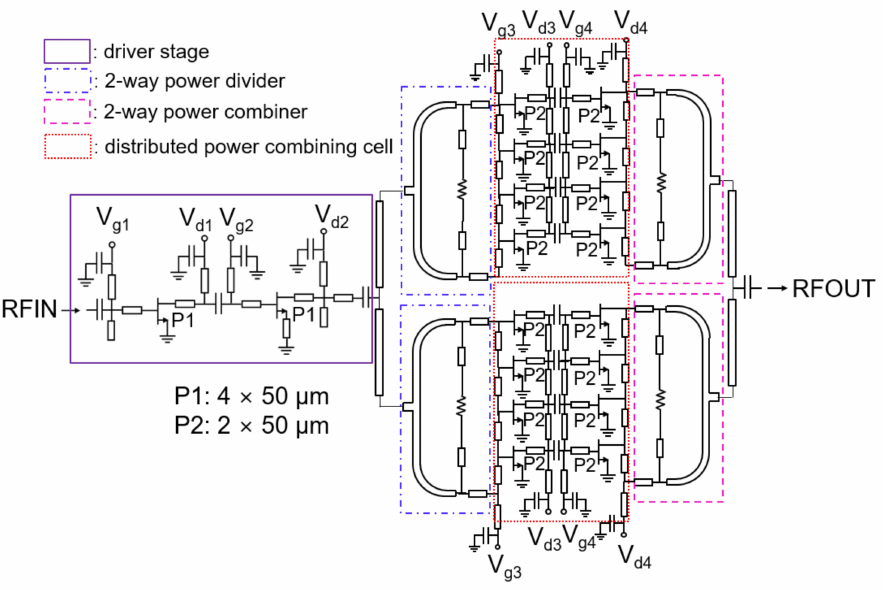
Figure 8. Schematic of the proposed PA.